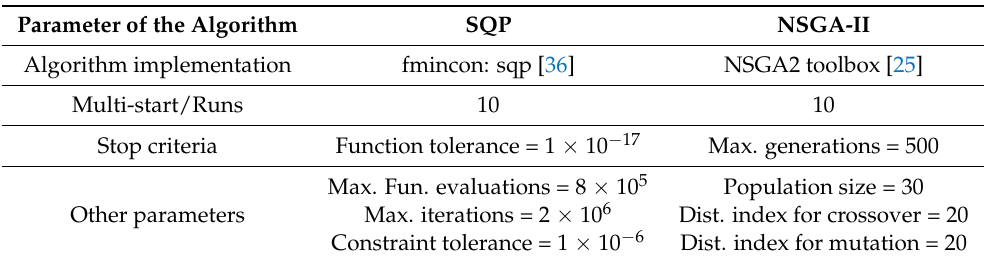
Table 2. Parameters of the optimization algorithms used for this experiment sequential quadratic programming (SQP) and NSGA-II.